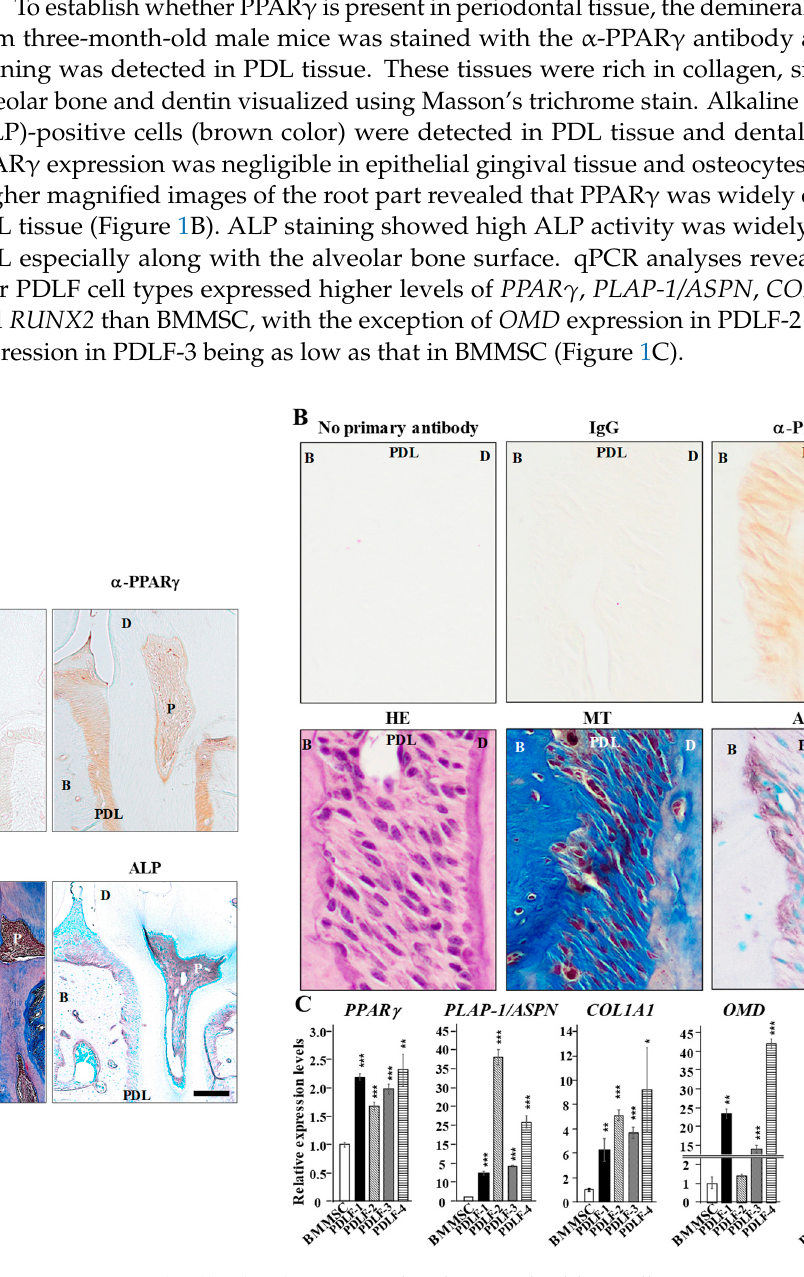
Figure 1. PPAR γ expression in PDL tissue and cells . ( A , B ) Demineralized 3-month-old maxilla sections were stained without the primary antibody or with mouse IgG or α -PPAR γ and were also stained with Masson’s Trichrome stain and ALP. ( C ) Total RNAs of PDLF-1, PDLF-2, PDLF-3, PDLF-4, and BMMSC were collected to quantify the expression of PPAR γ , PLAP-1/ASPN , COL1A1 , OMD , and RUNX2 . HPRT was used for normalization. * p < 0.05; ** p < 0.01; *** p < 0.001 significantly higher than BMMSC cells. Scale bars correspond to 200 µ m ( A ) and 50 µ m ( B ). MT = Masson’s Trichrome staining.